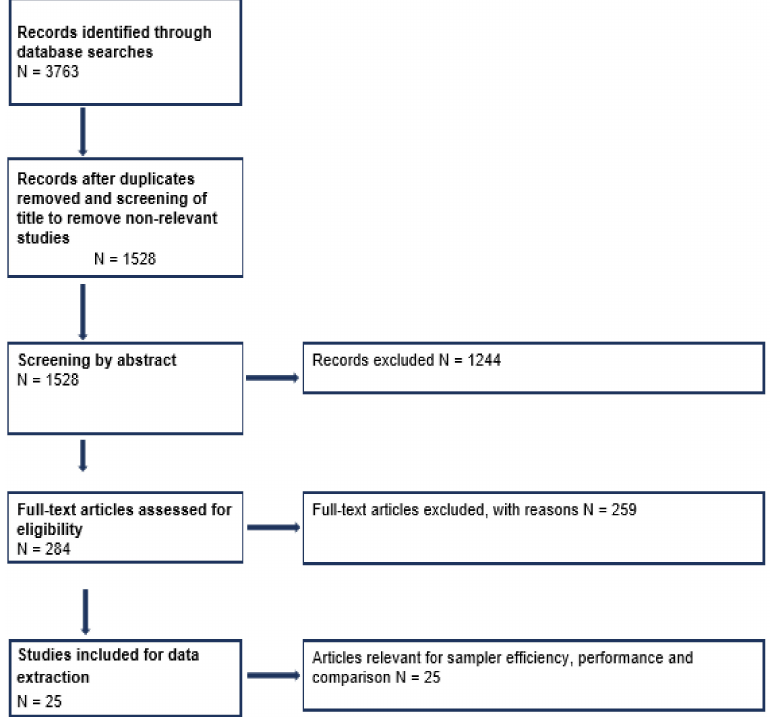
Figure 1. PRISMA flow diagram for laboratory-based aerosol sampler efficiency, performance and comparison studies